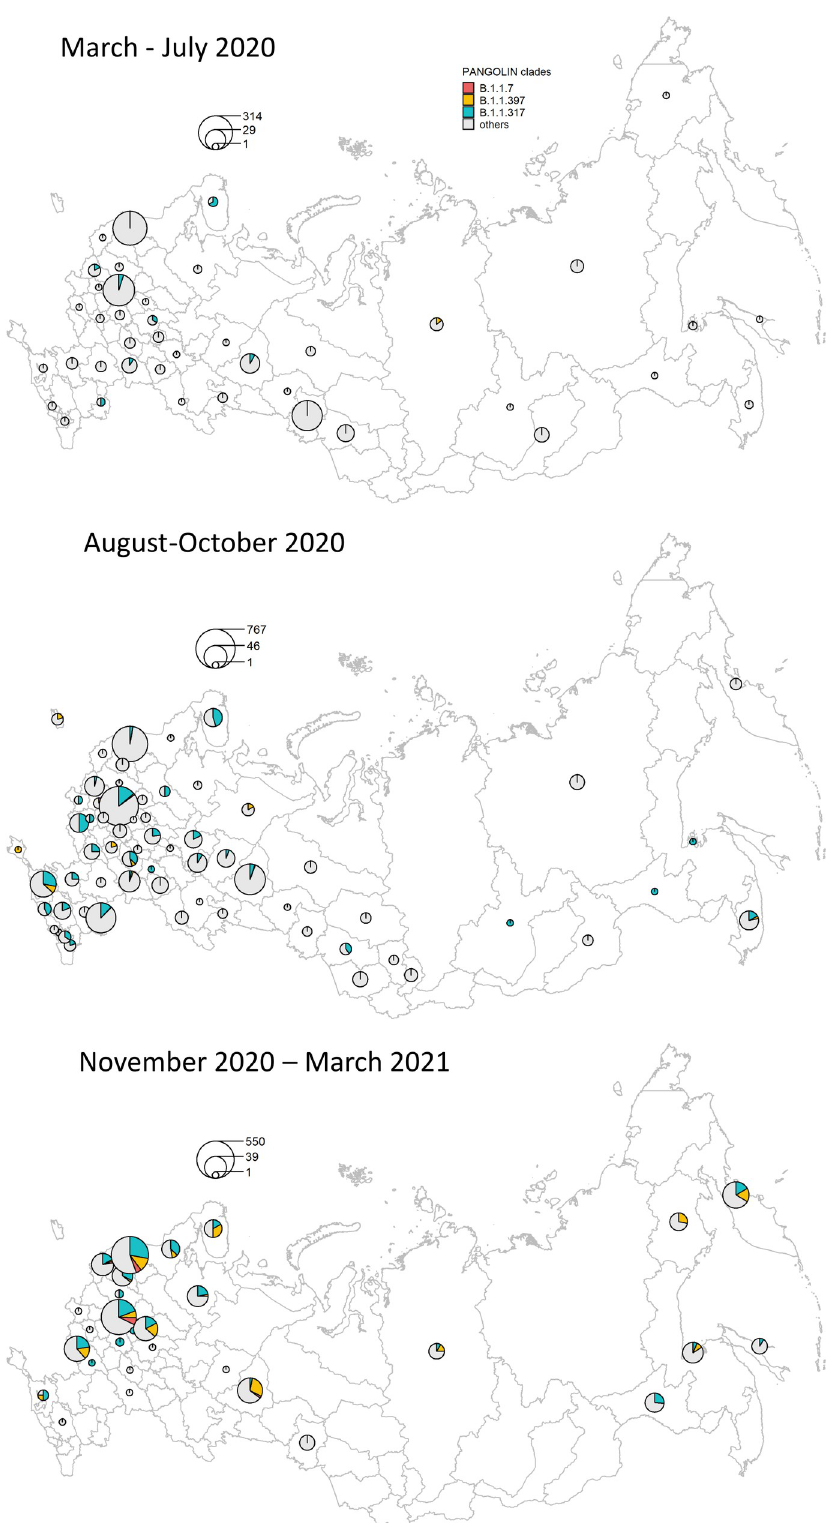
Fig 2. The spatio-temporal distribution of lineages that were frequent in Russia before April 2021.